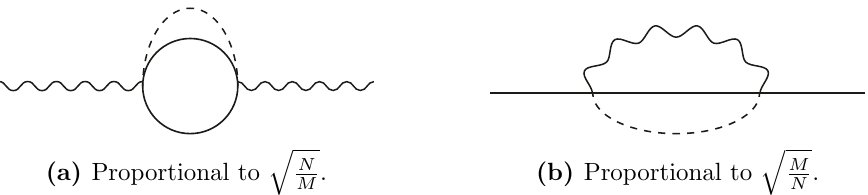
Figure 1. In this (cid:12)gure we show the two one-loop corrections to the two point functions. The solid lines indicate fermions, the wiggly lines the bosons and the dotted line shows the disorder average. Below the diagrams we show the power of M=N to which they are